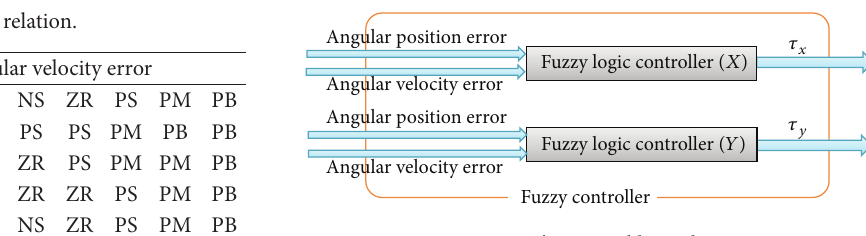
Figure 6: The control law schema.